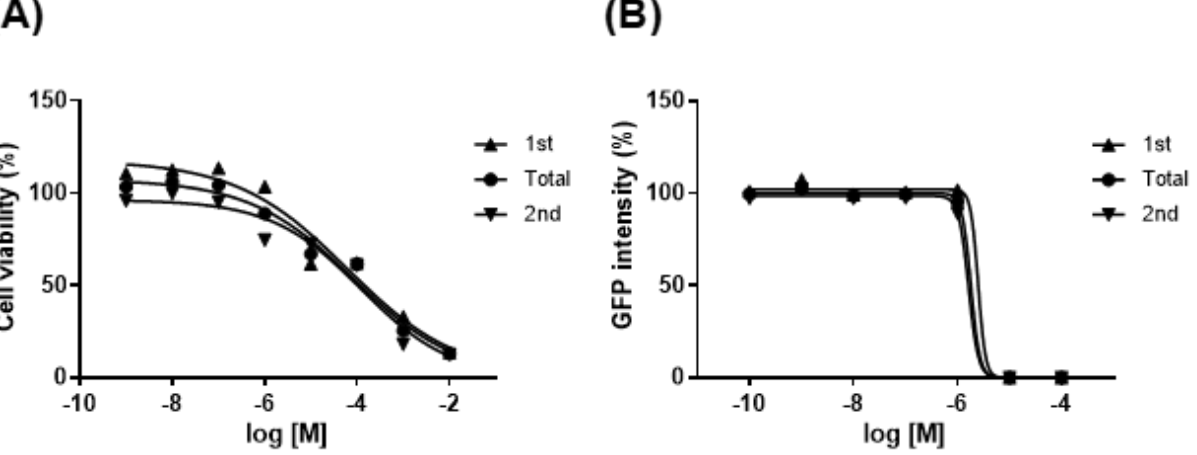
Figure 2. Discrimination of D5 as a developmental neurotoxicant by DNT: ( A ) cell survival curve of 46C; ( B ) logarithmic curve of the fluorescence intensity of GFP in